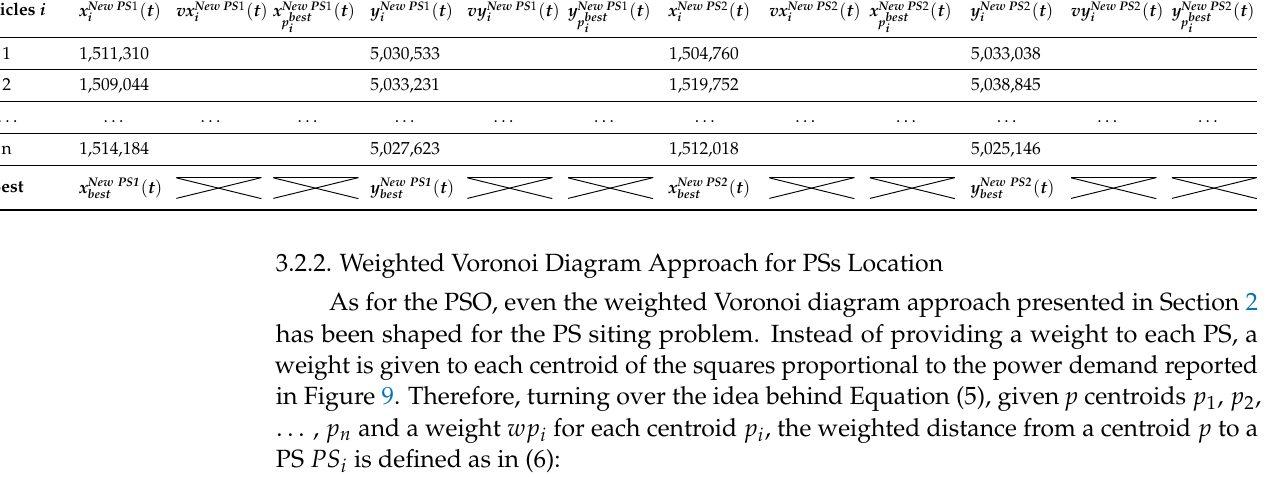
Table 2. Matrix of particle ’ s velocity, personal best, and global best.